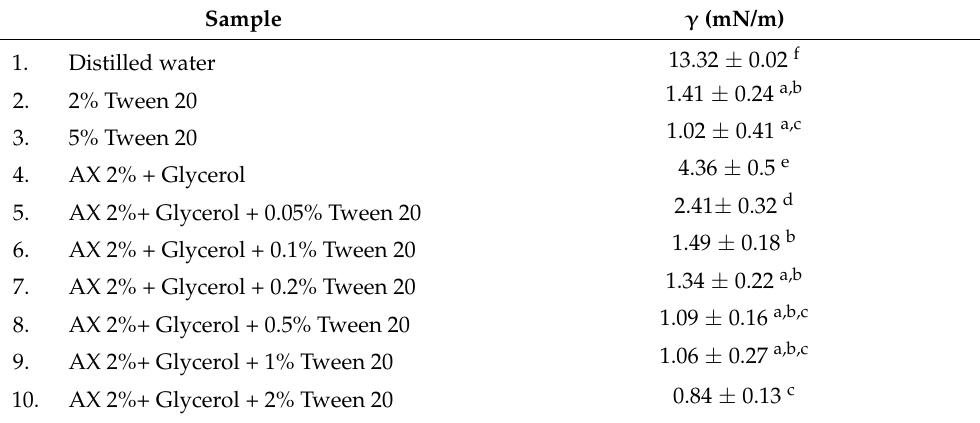
Table 2. Interfacial tension results ( γ , mN/m) between each aqueous solution and oleic acid. Values in the same column followed by different superscript letters differ significantly ( p <